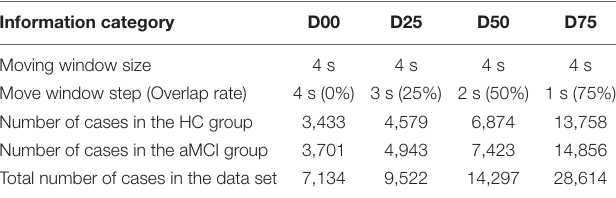
TABLE 1 | Description information of four segmented data sets.